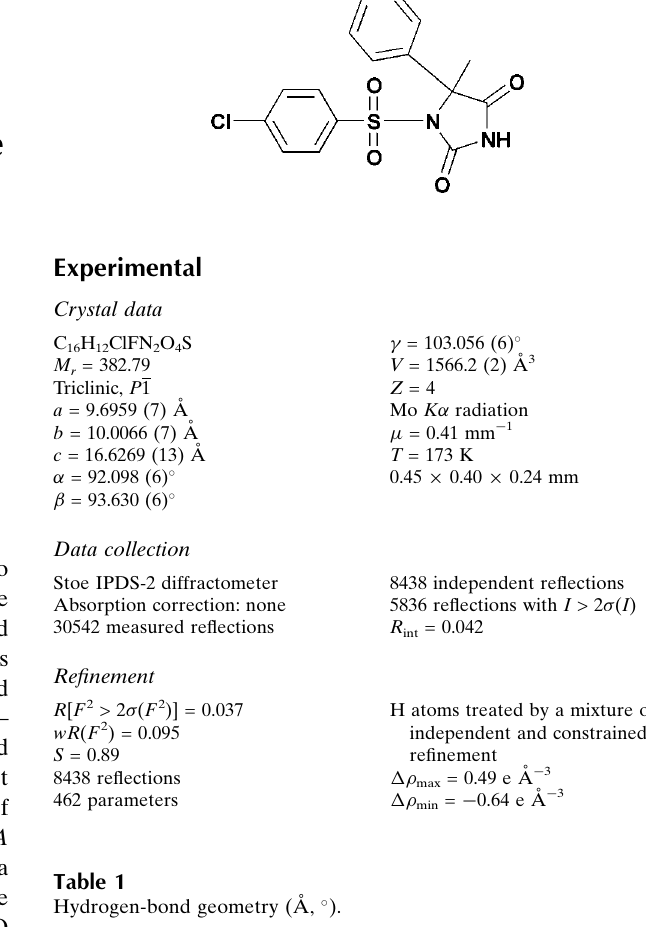
Hydrogen-bond geometry (A˚ , (cid:1)